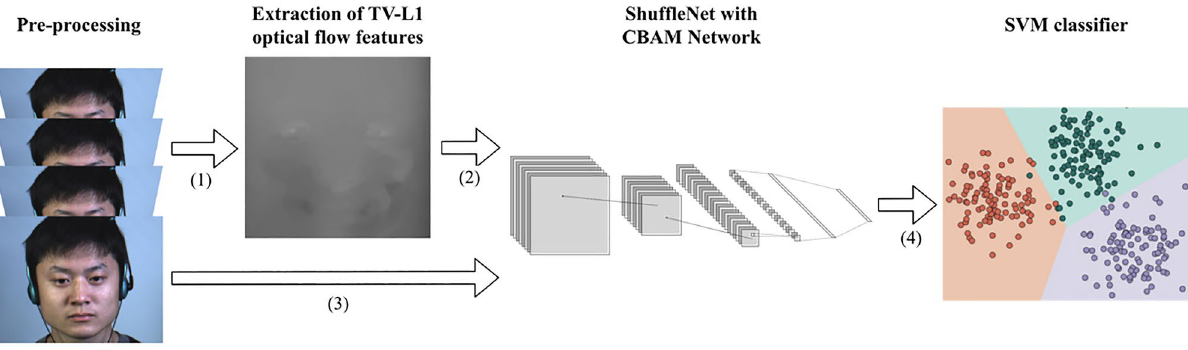
Figure 1. Micro-expression recognition model. (1) Obtain the start frame and vertex frame from the pre- processed sequence and extract the TV-L1 optical flow features between them. (2) Feed the optical flow features into the improved ShuffleNetV2 for pre-training and get the weights. (3) Load the weights and feed the pre-processed dataset into the improved ShuffleNetV2. (4) Use the SVM classifier in training for classification. Images are from subject 1 of the CASME II dataset 6 and is reproduced here following the CASME2 license agreement. Copyright © Xiaolan